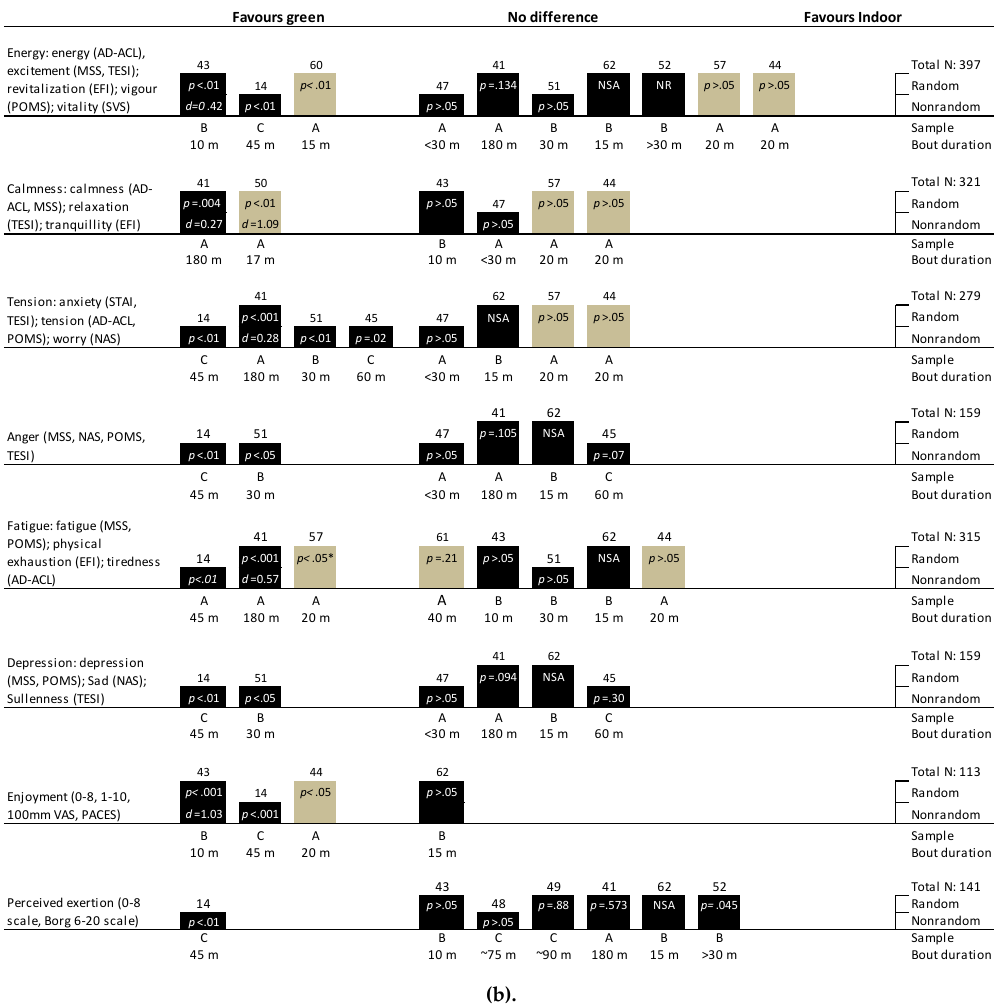
Figure 4. Harvest plots of trials investigating the e ff ects of outdoor green exercise versus indoor green exercise without exposure to nature on (a) general a ff ect and (b) emotions and perceived exertion. Note: A: studies with ≥ 40 participants; B: studies with 20–39 patients; C: studies with < 19 patients. We also provide the total sample across trials for each comparison. The taller bars represent randomized trials in this comparison, and shorter bars represent non-randomized trials. Grey bars indicate parallel group design trials, whereas black bars represent crossover design trials. p -values and e ff ect sizes (i.e., Cohen’s d) are provided inside each bar where this information is available. Exercise bout duration is provided in minutes (Kerr et al. 2006 [47] consisted of 5-km runs which we characterized as less than 30 min; whereas Turner et al. 2017 [52] included 6-km runs which we characterized as > 30 min). The number on top of each bar represents each study’s reference: 14 = Harte & Eifert 1995 [14]; 41 = Niedermeier 2017 [41]; 43 = Focht 2009 [43]; 44 = Plante 2007 [44]; 45 = Teas 2007 [45]; 47 = Kerr 2006 [47]; 48 = McMurray 1998 [48]; 49 = Mieras 2014 [49]; 50 = Nisbet 2011 [50]; 51 = Peacock 2007 [51]; 52 = Turner & Stevenison 2017 [52]; 57 = Plante 2003 [57]; 59 = Rider & Bodner 2016 [59]; 60 = Ryan 2010 [60]; 61 = Byrka & Ryczko 2018 [61]; 62 = Rogerson 2016 [62]. Acronyms: AD-ACL: Activation–Deactivation Adjective Check List; BDST: Backwards Digit Span Test; EFI: Exercise-Induced Feeling Inventory; FS: Feeling Scale; FAS: Felt Arousal Scale; GAS: General a ff ect scale; MSS: Mood Scale Score; NAS: Negative A ff ect Scale; PACES: Physical Activity Enjoyment Scale; PANAS: Positive and Negative A ff ect Schedule; PAS: Positive A ff ect Scale; POMS: Profile Of Mood States; STAI: State-Trait Anxiety Inventory; SVS: Subjective Vitality Scale; TAF: Tammen Attentional Focus; TESI: Tension and E ff ort Stress Inventory; VAS: Visual Analogue Scale; TMD: Total Mood Disturbance. * Internal replication